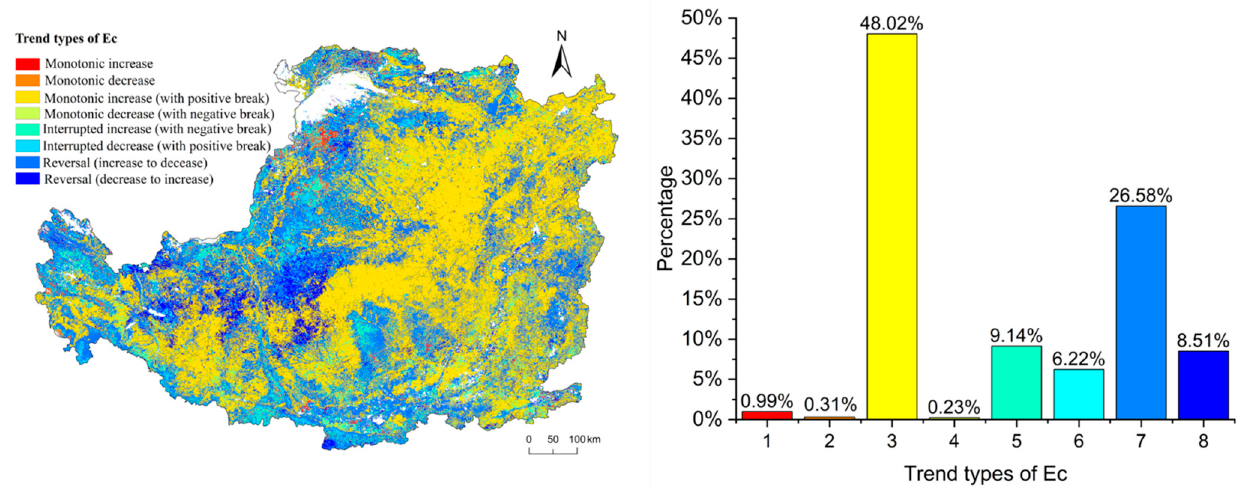
Figure 7. Spatial distribution and the percentage of different types of